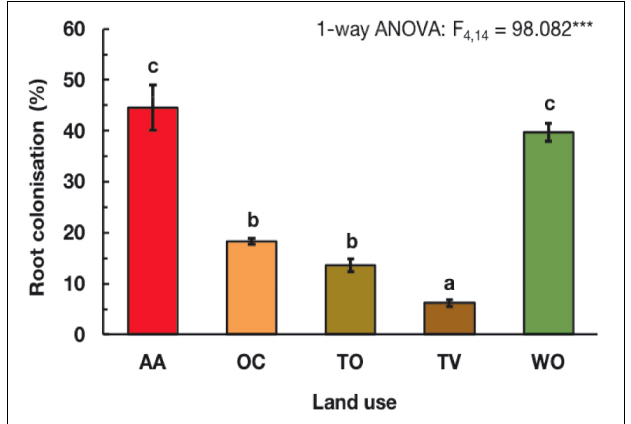
FIGURE 2 | Arbuscular mycorrhizal fungal root colonization (%) of English ryegrass ( Lolium perenne L.) under five land-use types. See Figure 1 for land-use abbreviations. Each bar represents the mean value ± SE of three fields on different farms per land-use type. Different letters above the bars indicate statistically significant differences, according to the Tukey test at P ≤ 0.05, following a one-way analysis of variance (ANOVA).